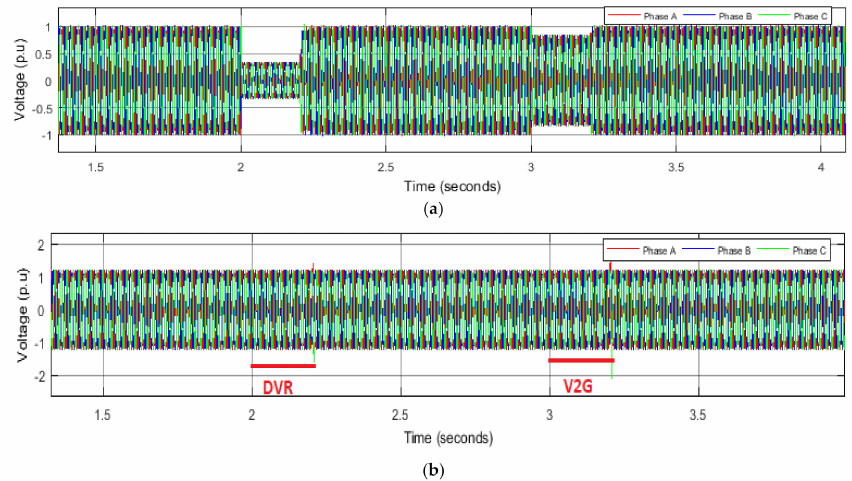
Figure 19. ( a ) Three phase symmetrical fault. As it can be seen for all the faults, the voltage sag intensity is between 0.51 to 0.2 p.u for 2 to 2.2 s and between 0.9 to 0.5 p.u of nominal voltage for 3 to 3.2 s respectively. ( b ) Voltage compensation using DVR and V2G for three phase faults. The intensity of the fault between 2 to 2.2 s is severe hence DVR provides voltage